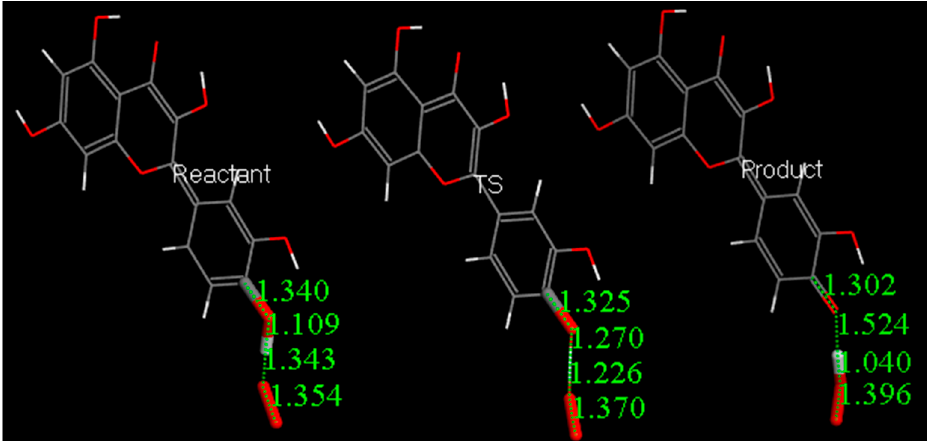
Figure 16. DFT scavenging of superoxide by quercetin. Minimized Reactant, transition state (TS) and Product.